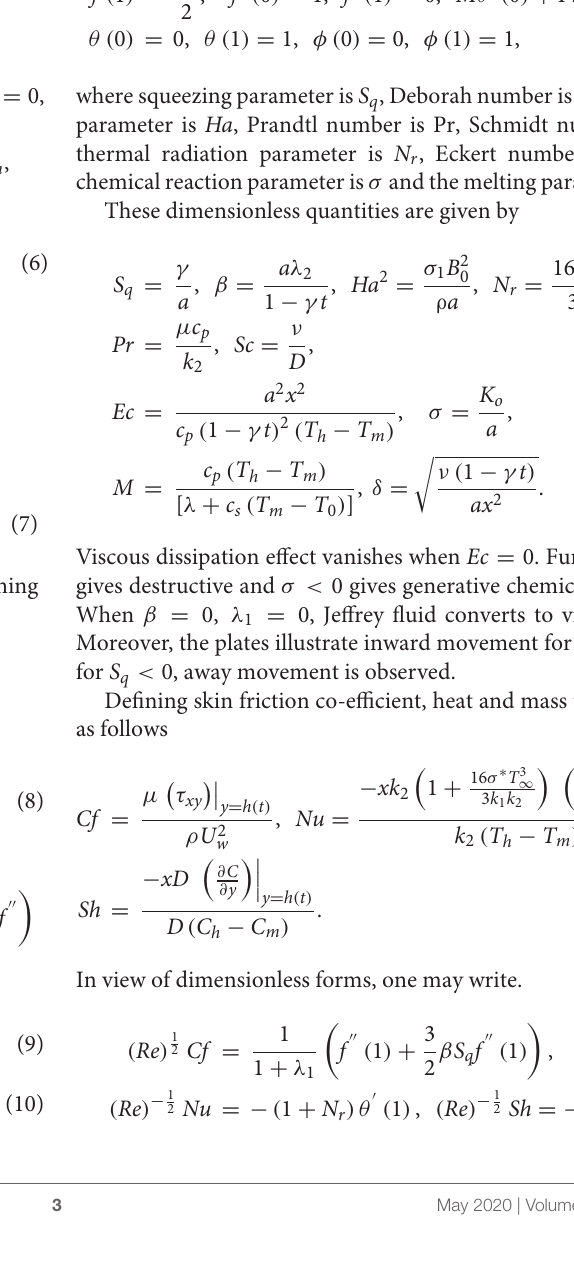
denotes the Stefan-Boltzmann constant, D is the diffusion co- efficient, ν is the kinematics viscosity, K ( t ) = K 0 / 1 − γ t is time- dependent reaction rate with reaction rate K 0 , λ 1 is relaxation time and λ 2 is ratio among relaxation and retardation